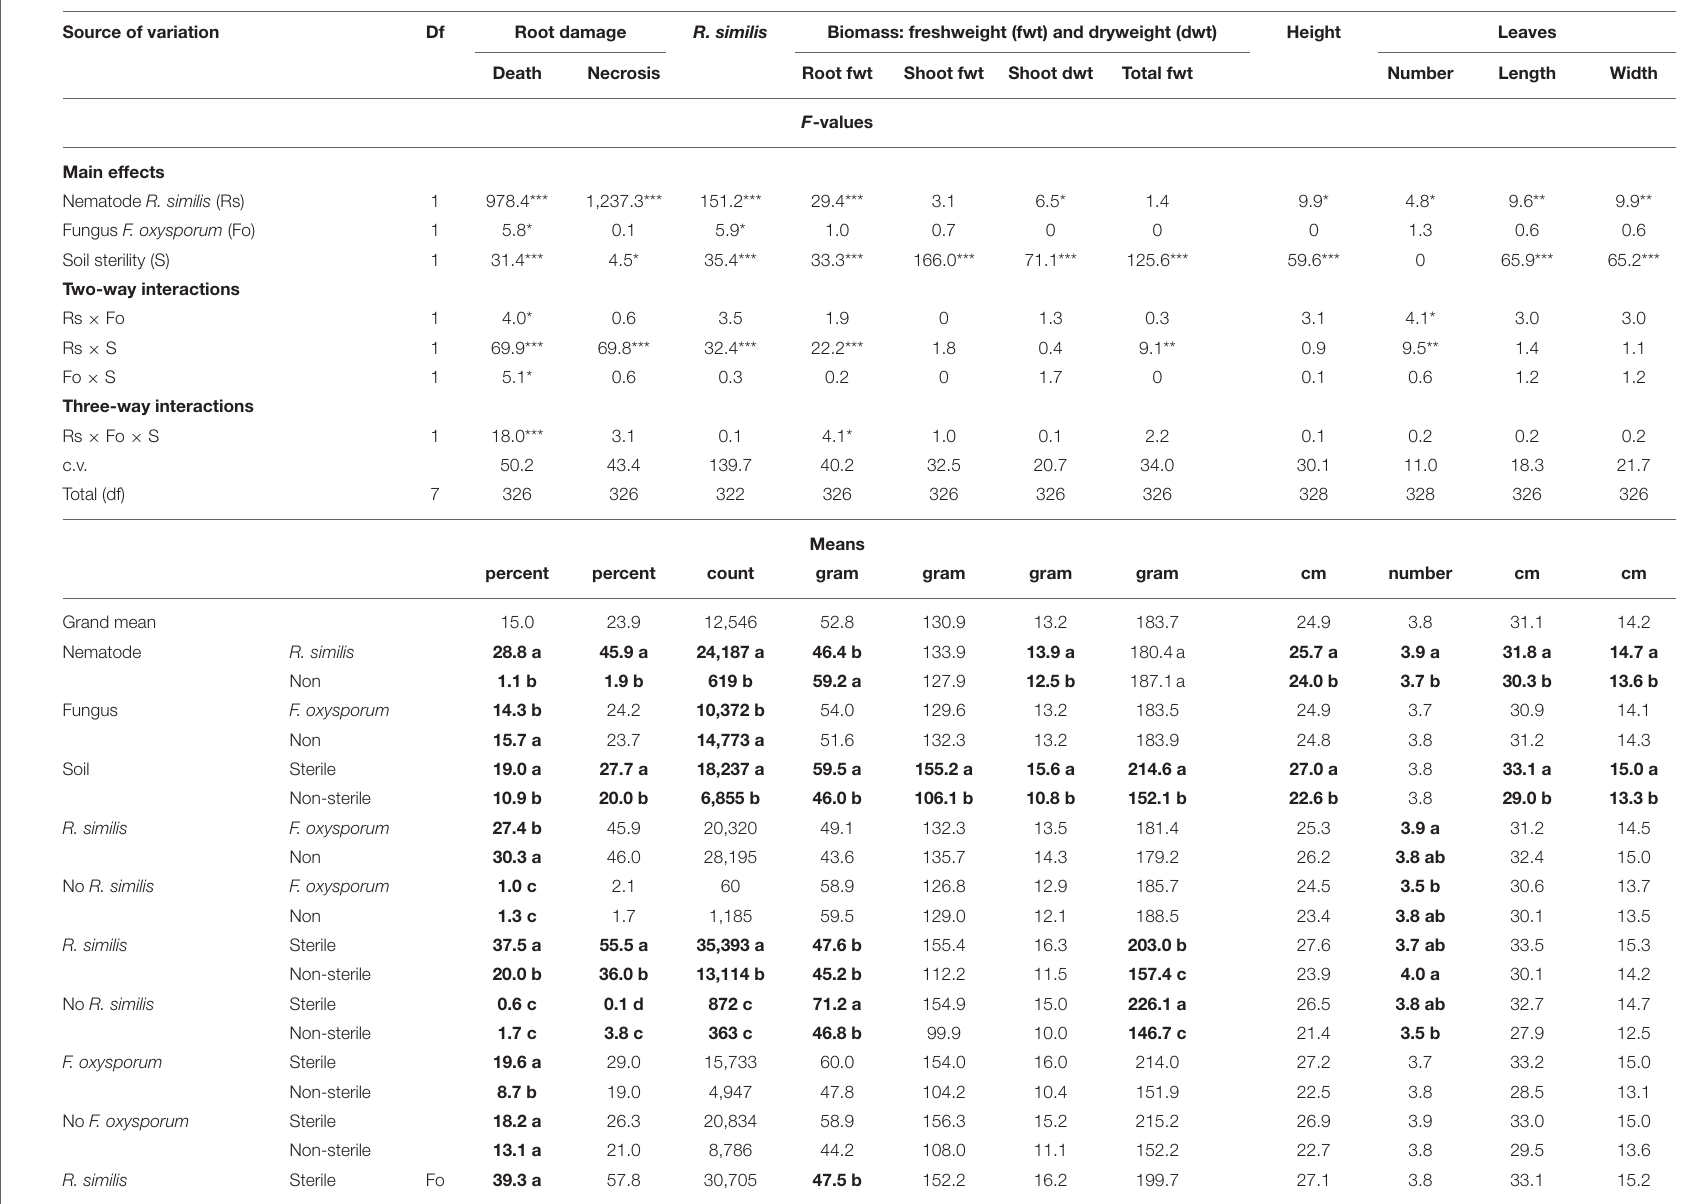
TABLE 2 | Effect of soil sterility on infection symptoms of Radopholus similis and Fusarium oxysporum V5w2 in tissue culture banana plants grown under nitrogen deficient conditions. Source of variation